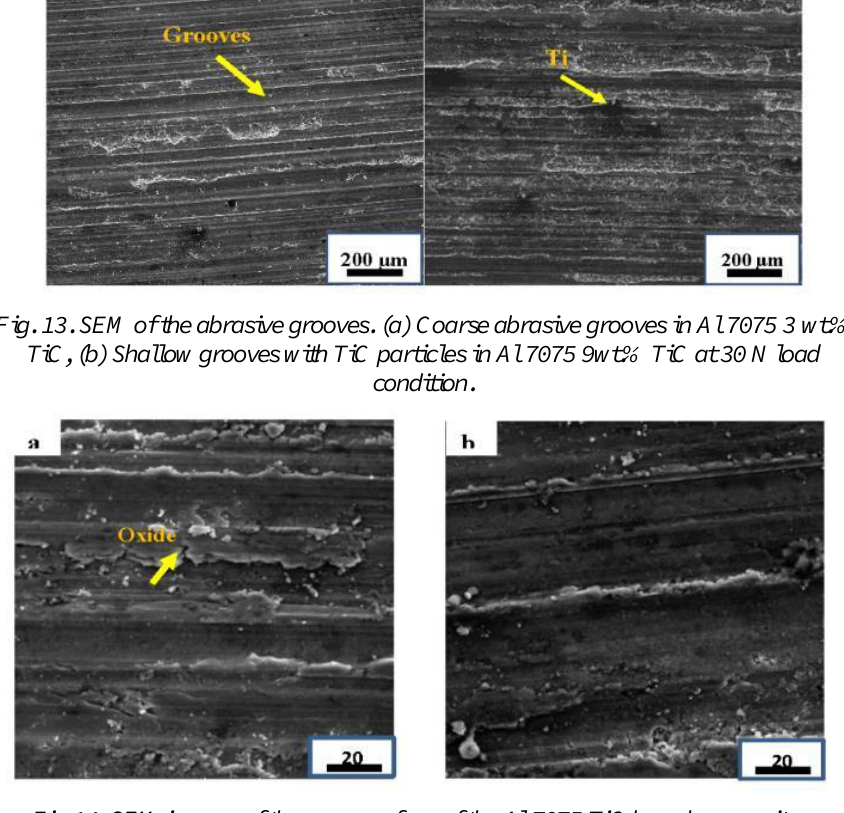
Fig 14. SEM images of the wear surface of the Al 7075 TiC based